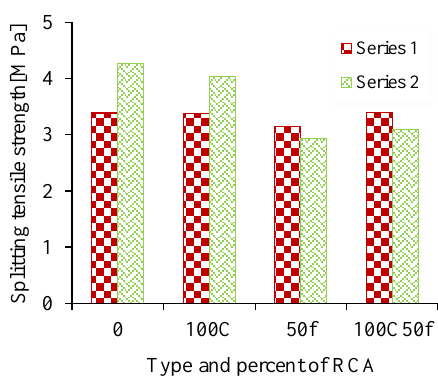
Figure 9. Tensile strength results at 28 days.